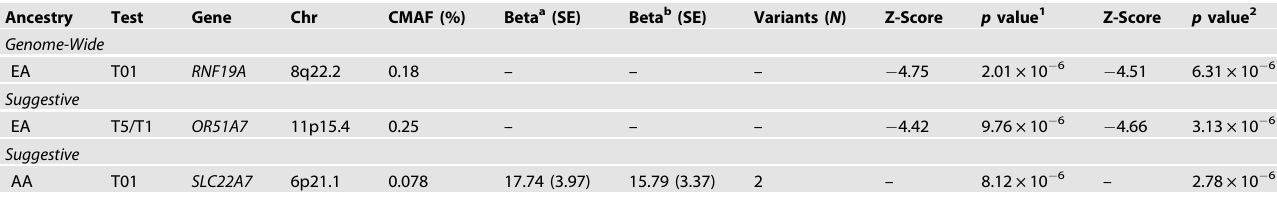
Table 2. Gene-based analysis of association of low-frequency variants and DSST scores.